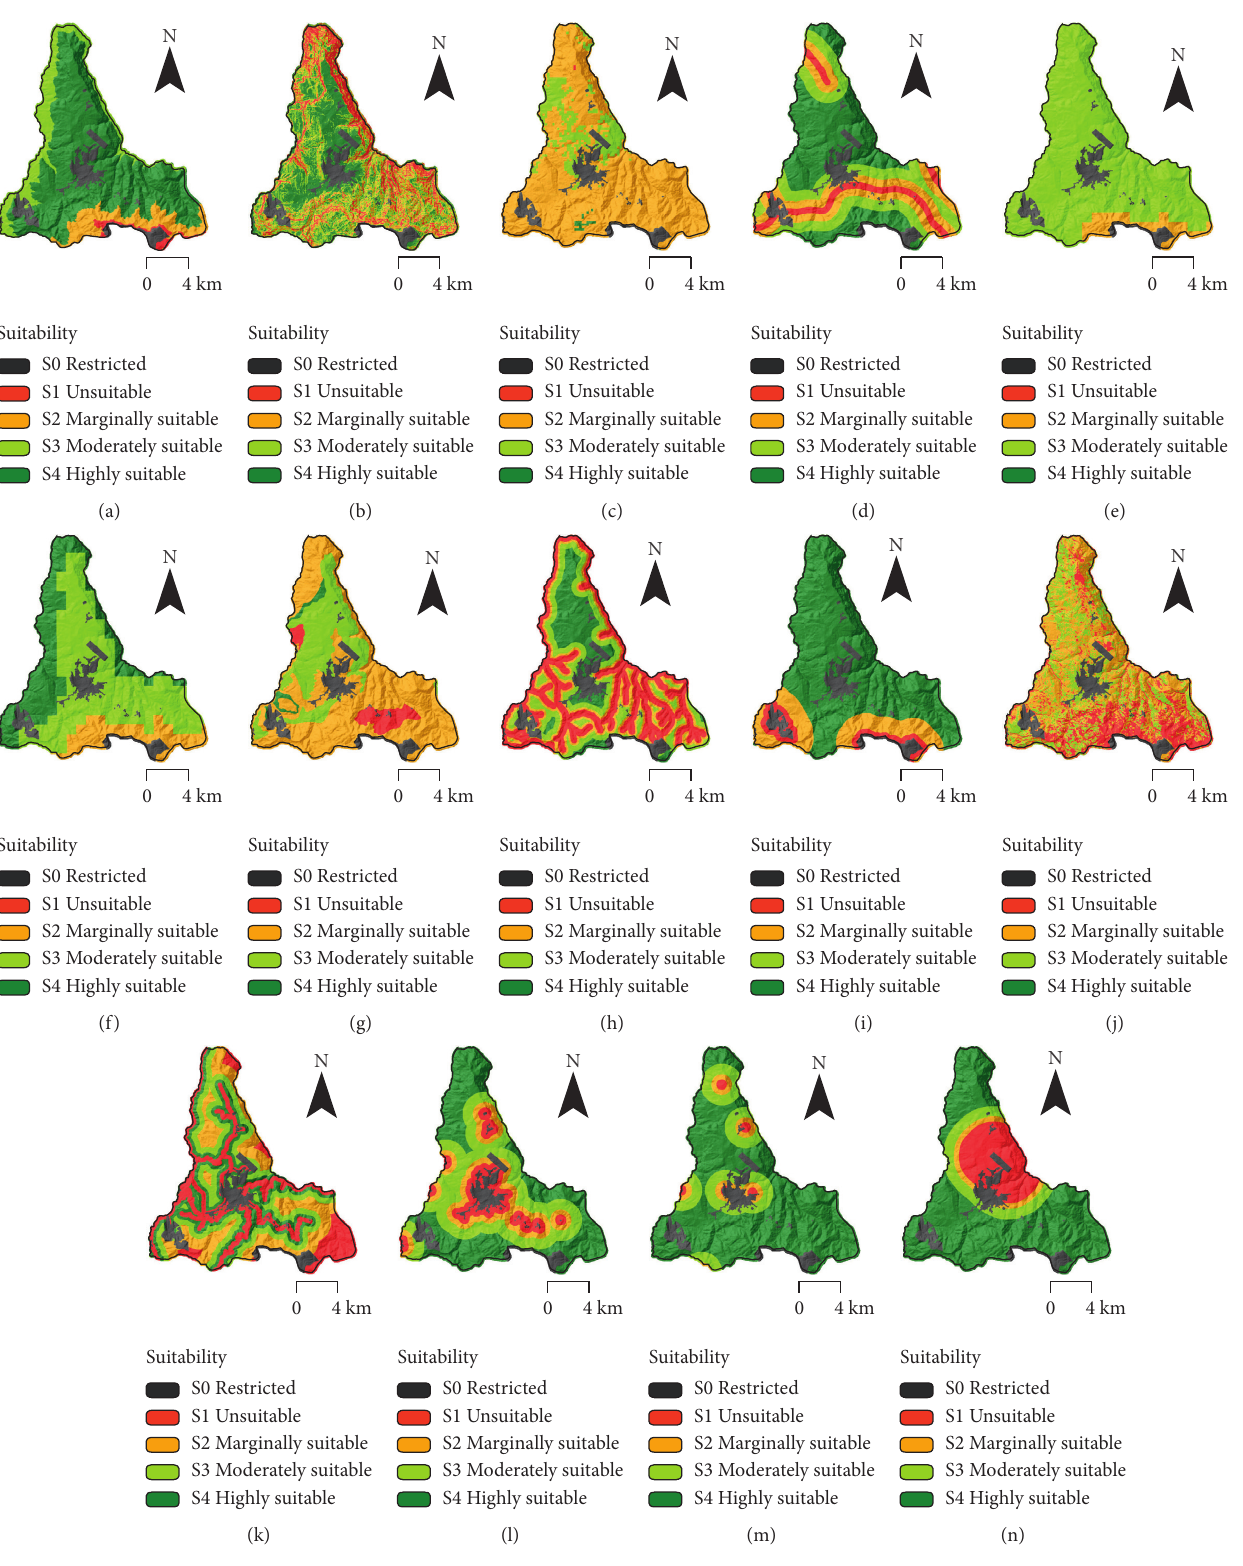
Figure 4: Maps of suitability subcriteria under the thresholds for suitable sites to locate a Chachapoyas landfill, NW Peru. (a) Elevation. (b) Slope. (c) Soil texture. (d) Proximity to geological fault. (e) Average annual precipitation. (f) Average annual temperature. (g) Geology type. (h) Proximity to a water source. (i) Protected natural areas (PNA). (j) Land use/land cover. (k) Proximity to access to roads. (l) Proximity to urban areas. (m) Proximity to tourist centers. (n) Proximity to the